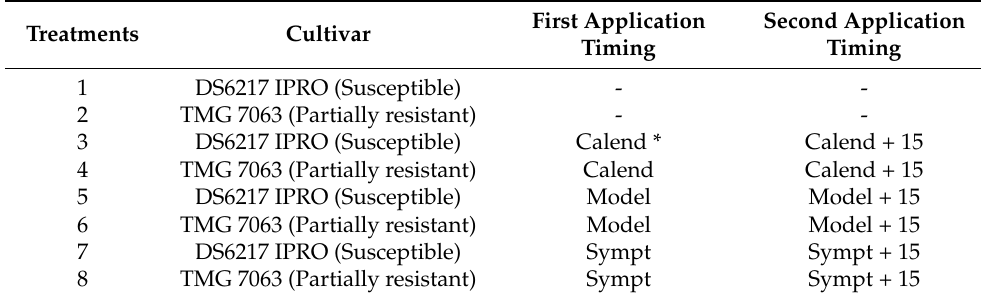
Table 1. Description of the treatments according to the soybean cultivar and application timing. Treatments